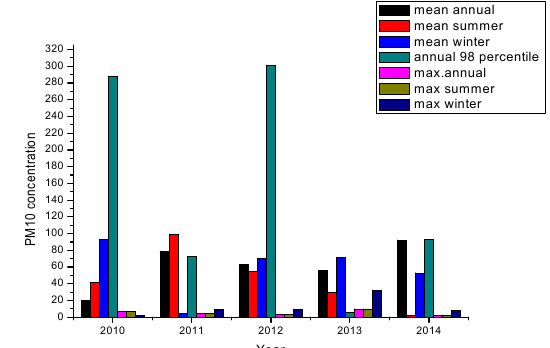
Fig. 1. PM 10 concentrations (μg/m 3 ) as input in model in years 2010-2014